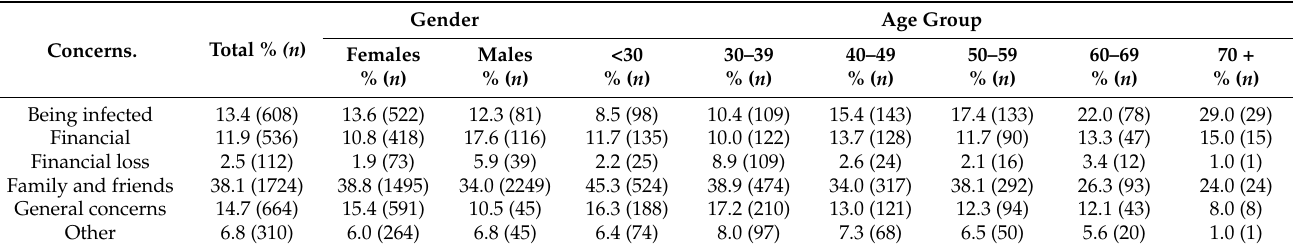
Table 2. Concerns that created the most